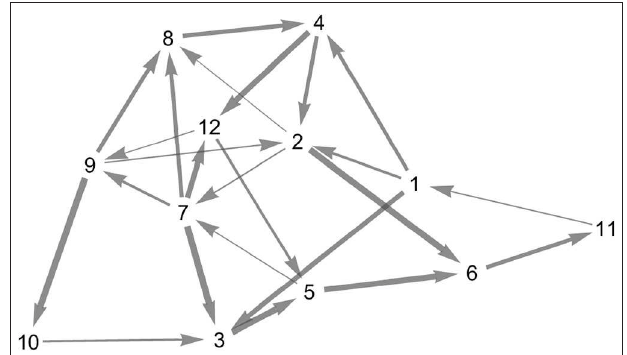
FIGURE 7 | Topology of the random heteroclinic network G . The edge thickness is determined by the magnitude of the expanding eigenvalue at the node from which the respective heteroclinic orbit originates.